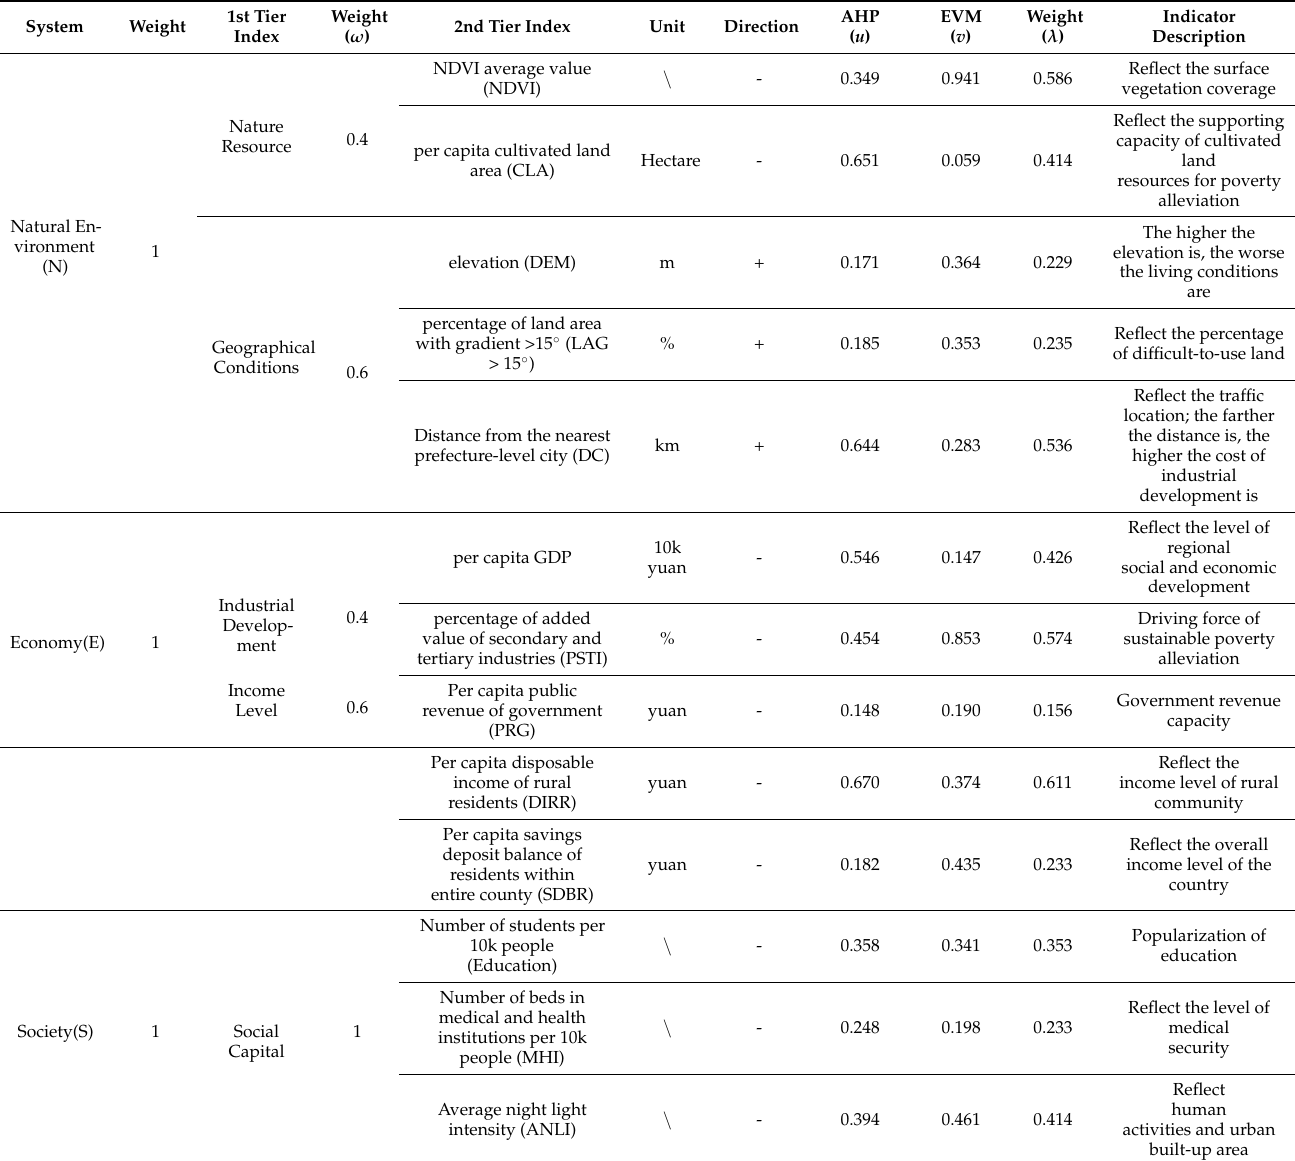
Table 1. Framework of the comprehensive poverty